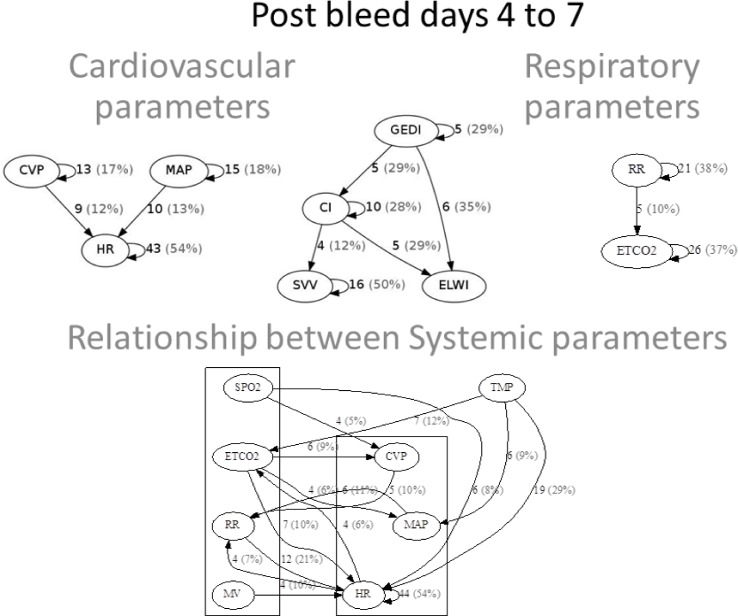
Causal relationships between systemic physiologic parameters during the second post injury phase (days 4 to 7).Cardiovascular (top row, left panel), pulse contour analysis (top row, middle panel), respiratory (top row, right panel), and cardio-respiratory (bottom row) relationships.